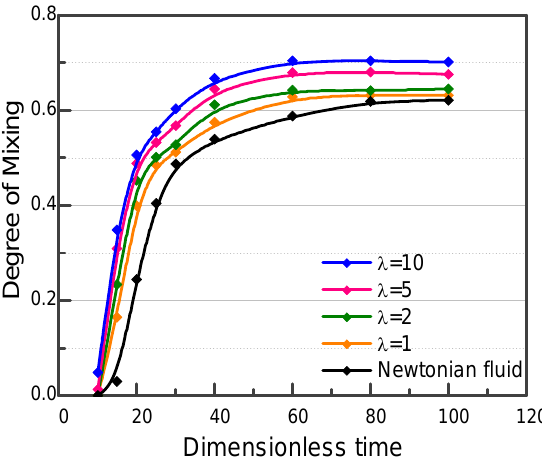
Figure 6. Degree of mixing in the Newtonian fluid case and viscoelastic fluid case with different relaxation time under modulating driving pressure at the inlet I 1 and constant pressure at the inlet I 2.